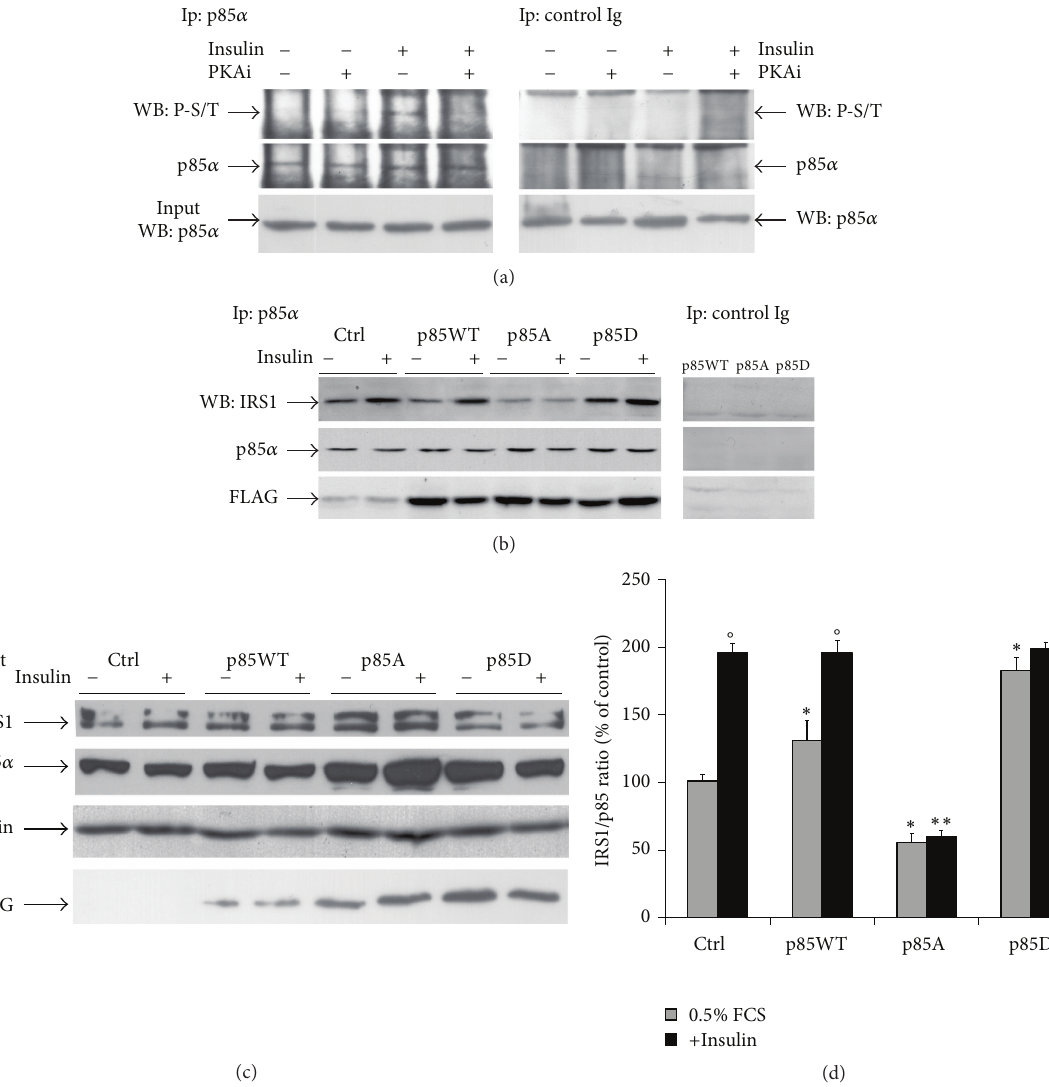
Figure 1: Phosphorylation of p 85𝛼 PI 3 K S83 modulates the IRS-1/p85 interaction. Total protein extract obtained from MCF-7 cells untreated and treated with 10nM insulin for 10min in the pretreated or not with 10 𝜇 g/mL PKAi for 15min was immunoprecipitated with anti-p85 𝛼 antibody and probed with anti-phospho (Ser/Thr) PKA substrate antibody (P-S/T) (a). MCF-7 cells transfected with p85WT or p85A or p85D were serum starved for 6 h and treated with 10nM insulin for 10 min. Cell lysates were immunoprecipitated with anti-p85 antibody and then analysed by Western blot with anti-IRS-1, anti-p85, and anti-FLAG antibodies (b). p 85𝛼 PI 3 K , IRS-1, and 𝛽 -tubulin expression levels in input lysates were shown (c). The upper bands in the insert of IRS-1 are not displaced by the control peptide and are considered nonspecific signals (IRS1-specific bands are indicated by the arrow). The histogram (d) represents the quantitation of IRS-1/p 85𝛼 PI 3 K signals ratio obtained from different co-IP experiments. To minimize differences in transfection and/or antibody efficiency, the data shown in the panel (d) were obtained by the comparison of different experiments performed with anti-p85 𝛼 (three experiments), anti-IRS-1 (three experiments), and anti-FLAG ((three experiments; see Figure S2). The histograms show the fold variation relative to the untreated control cells of the ratio IRS-1/p85. Values are expressed as mean ± SD ( 𝑛 = 7 ). Differences between treatments were tested for statistical significance using Student’s matched pairs 𝑡 -test: ∘ 𝑃 < 0.01 versus 0.5% FCS treated cells; ∗ 𝑃 < 0.01 versus nontransfected cells; ∗∗ 𝑃 < 0.01 versus p 85𝛼 PI 3 K wild-type or p85D expressing cells or control cells after insulin